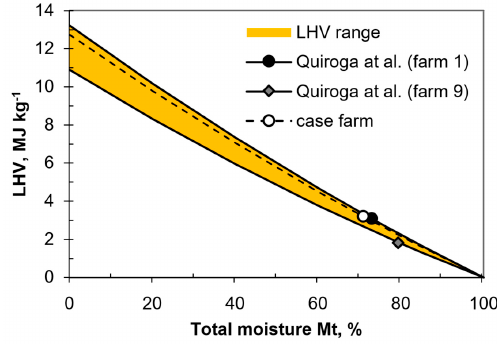
Figure 1. Lower heating value of manure from the cage system.